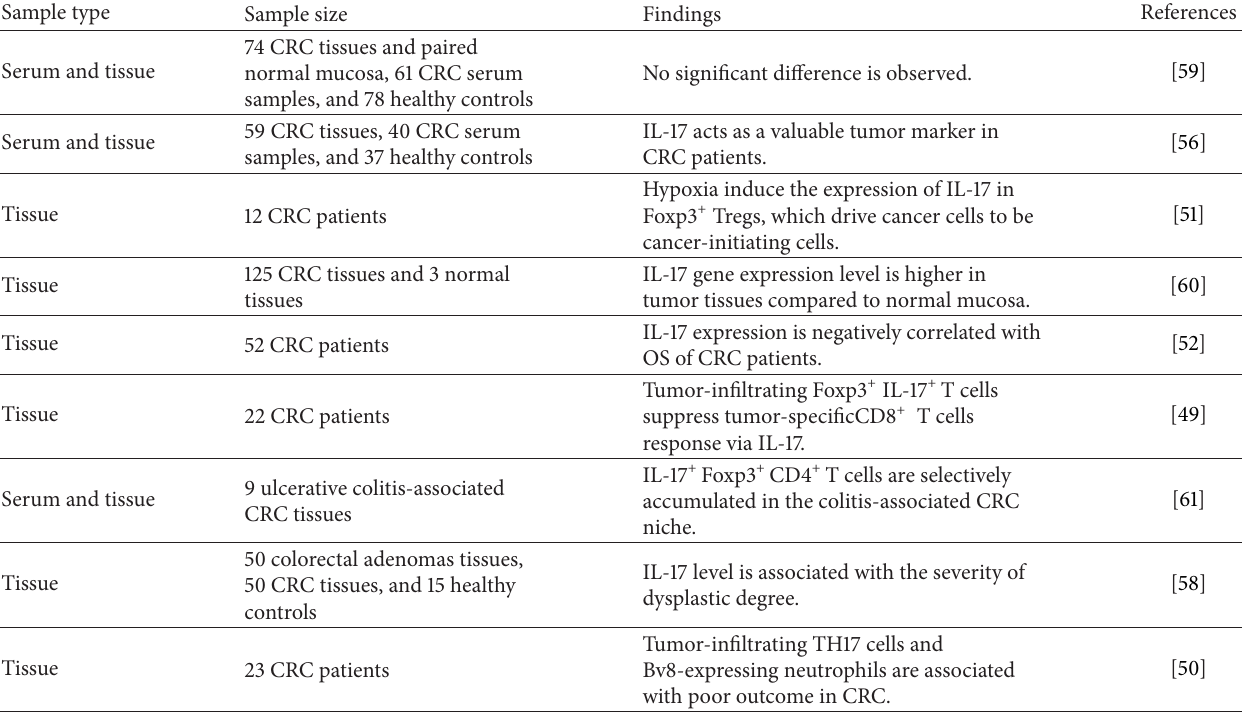
Table 2: Expression of IL-17 in CRC